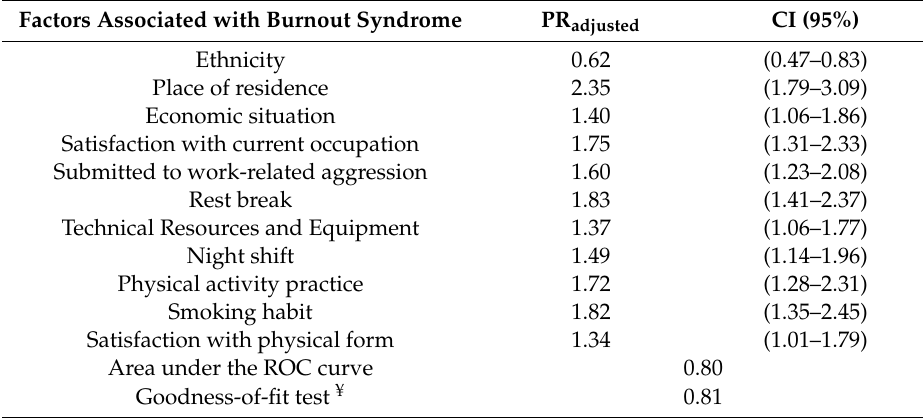
Table 4. Factors associated with Metabolic Syndrome in Primary Health Care nursing professionals, obtained by multivariate